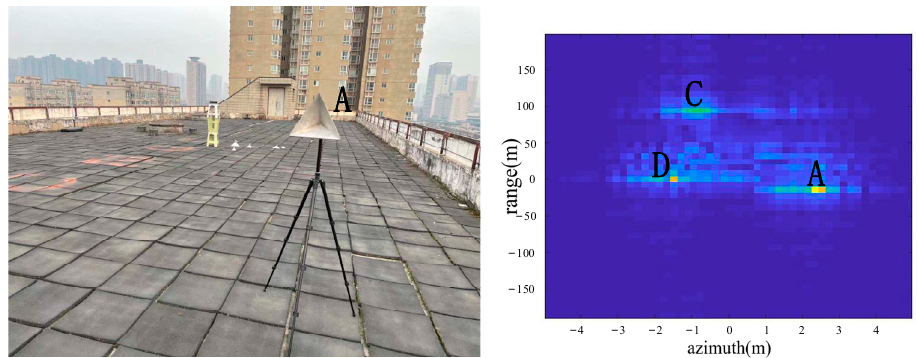
Figure 14. The 9th group of experimental scenes and imaging results. As shown in Figure 15, two corner reflectors A and B were placed 17 m (left) and 9 m (right) from the radar, respectively. The two corner reflectors A and B were 2.5 m apart in the azimuth direction. The corner reflector A was on the left, 17 m in the distance, and the corner reflector B was on the right, 9 m in the distance. A and B were both big corner reflectors. According to the imaging results, the positions of A, B, C and D were consistent with the positions of objects in the actual scene.